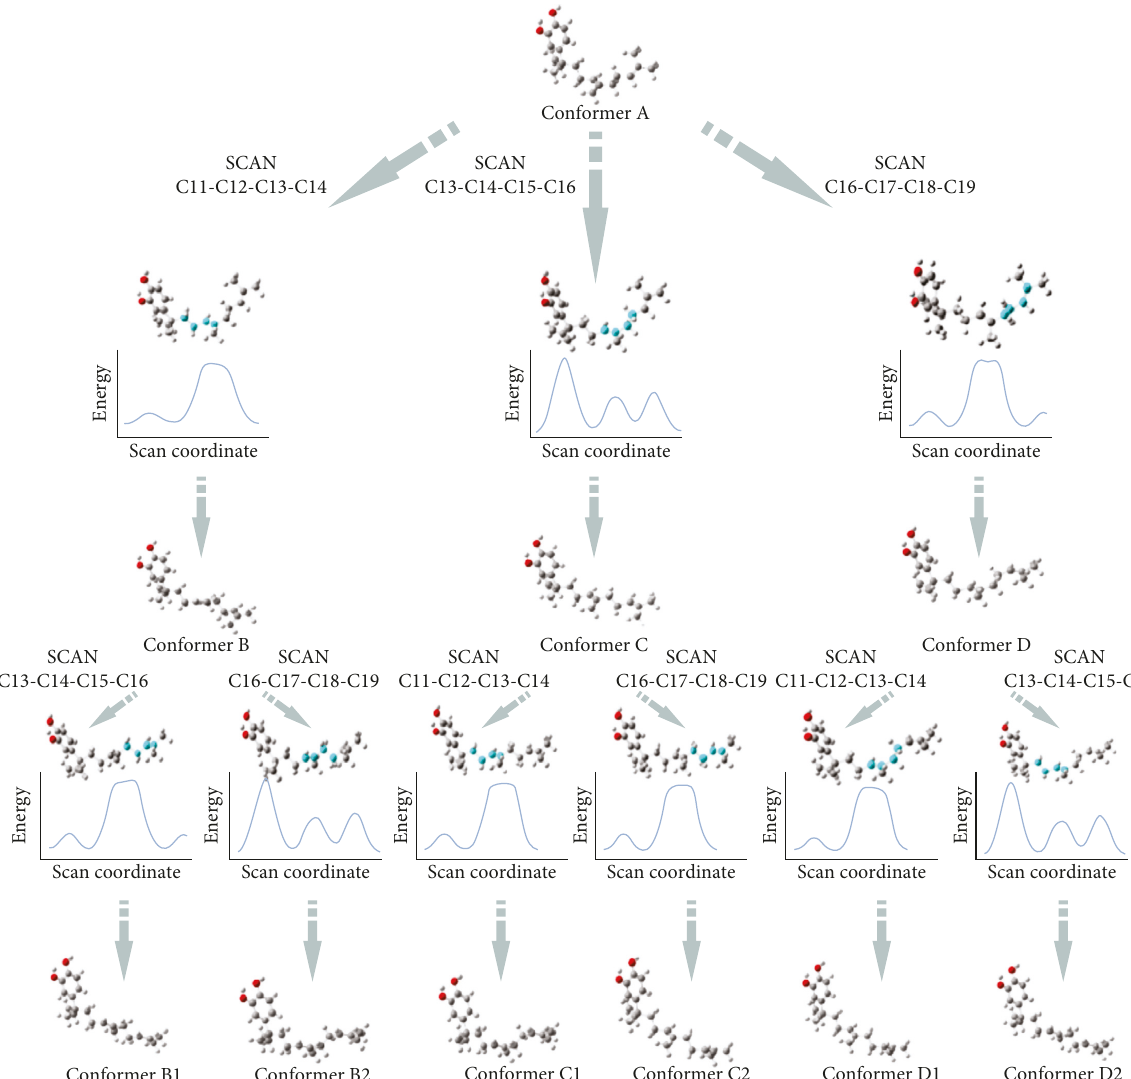
Figure 2: Scheme for potential energy surfaces (PES) analysis of